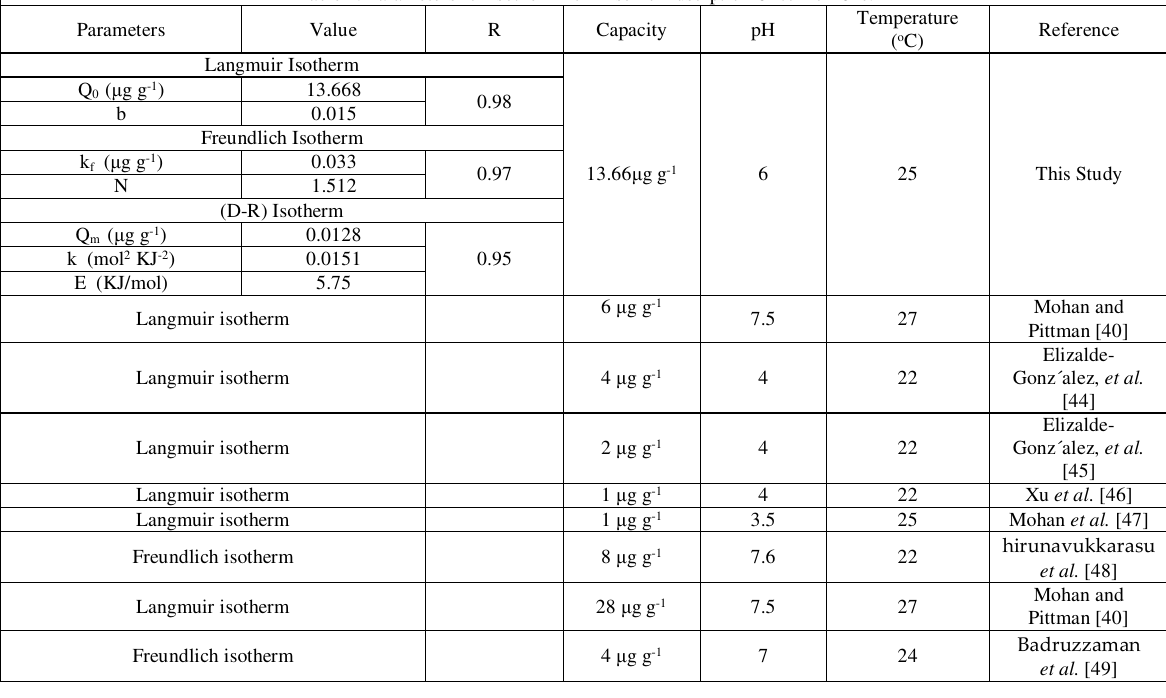
Table 2: Parameters for Isotherm for Arsenic Adsorption Onto Iron